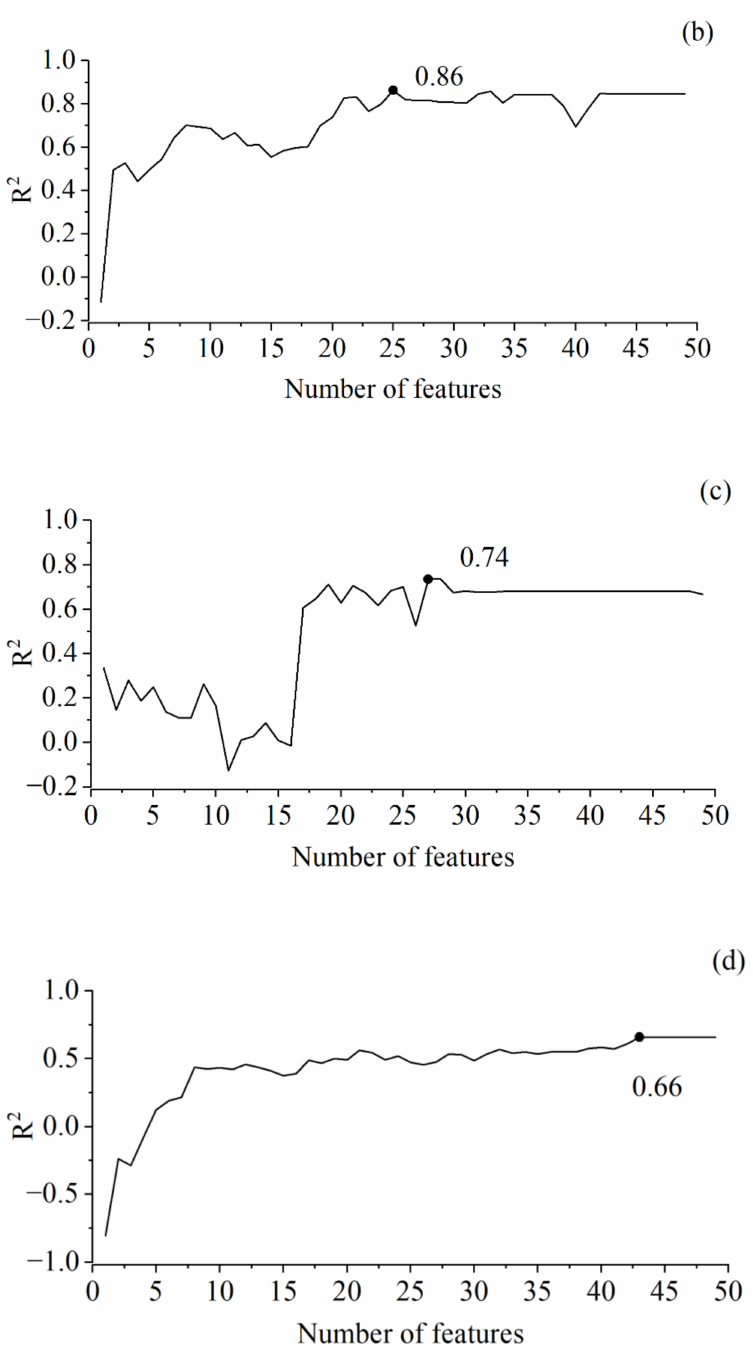
Figure 3. Coefficient of determination (R 2 ) of extreme gradient boosting (XGboost) changes with the selected features from digital elevation model (DEM), Sentinel-1, and Sentinel-2 under total area ( a ), orchard ( b ), dry land ( c ), and paddy field ( d